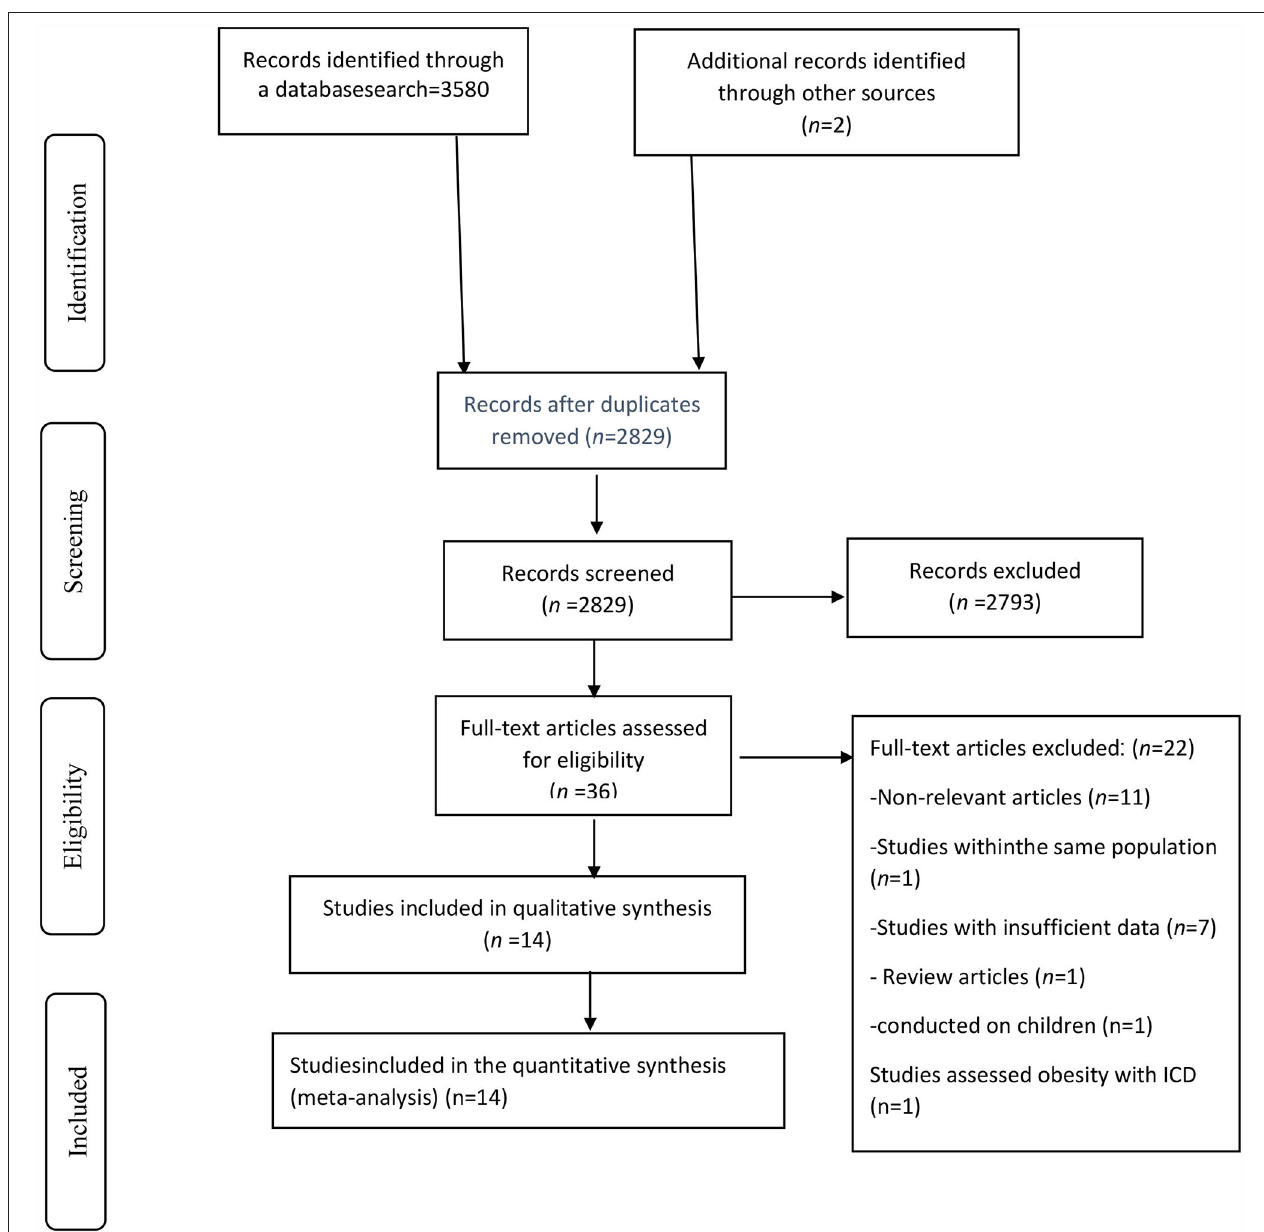
FIGURE 1 | Study selection flow